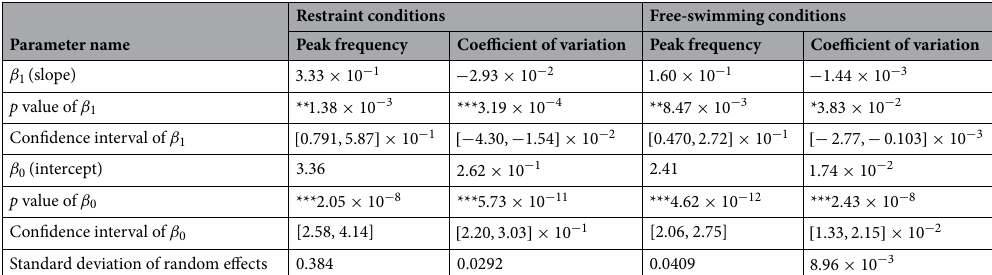
Table 1. Linear mixed model analysis for ventilation indices. 20 individuals were used for the restraint and free-swimming experiments. An individual included in the restraint experiment in the 50 mg/L dose group was excluded from analysis. (*: p < 0.05 , **: p < 0.001 , ***: p < 0.001